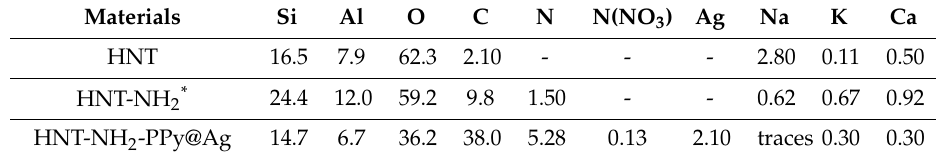
Table 2. Summary of surface chemical composition / Atomic percentage, determined from XPS, for HNT-DMA-PPy@Ag material and precursors. (-) represent the unavailable data or information. Materials Si